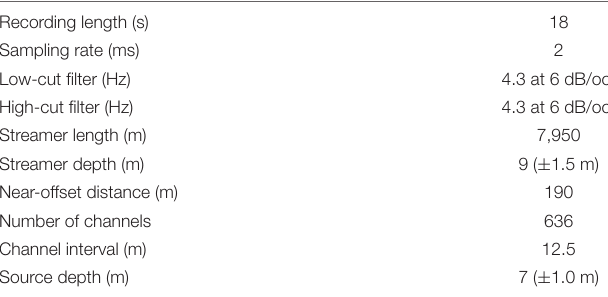
TABLE 1 | Summary of the acquisition parameters of the MCS profiles acquired in the